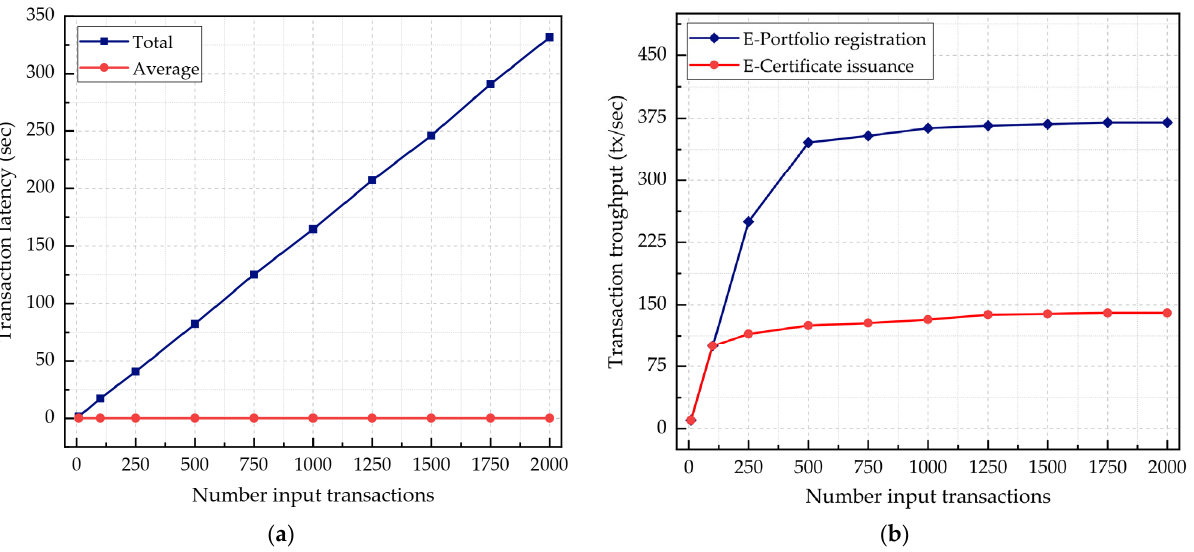
Figure 7. Transaction latency and throughput: ( a ) e-portfolio registration transaction latency mea- surements with variable input transaction rates; ( b ) e-portfolio registration and e-certificate issuance transaction throughput measurements with variable input transaction